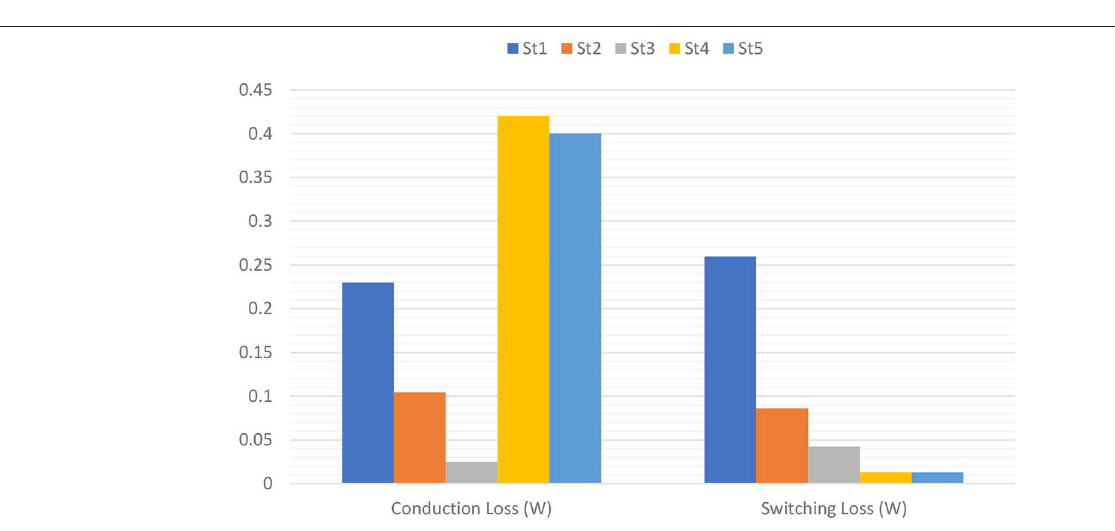
FIGURE 9 | Power loss analysis for seven-level inverter with five